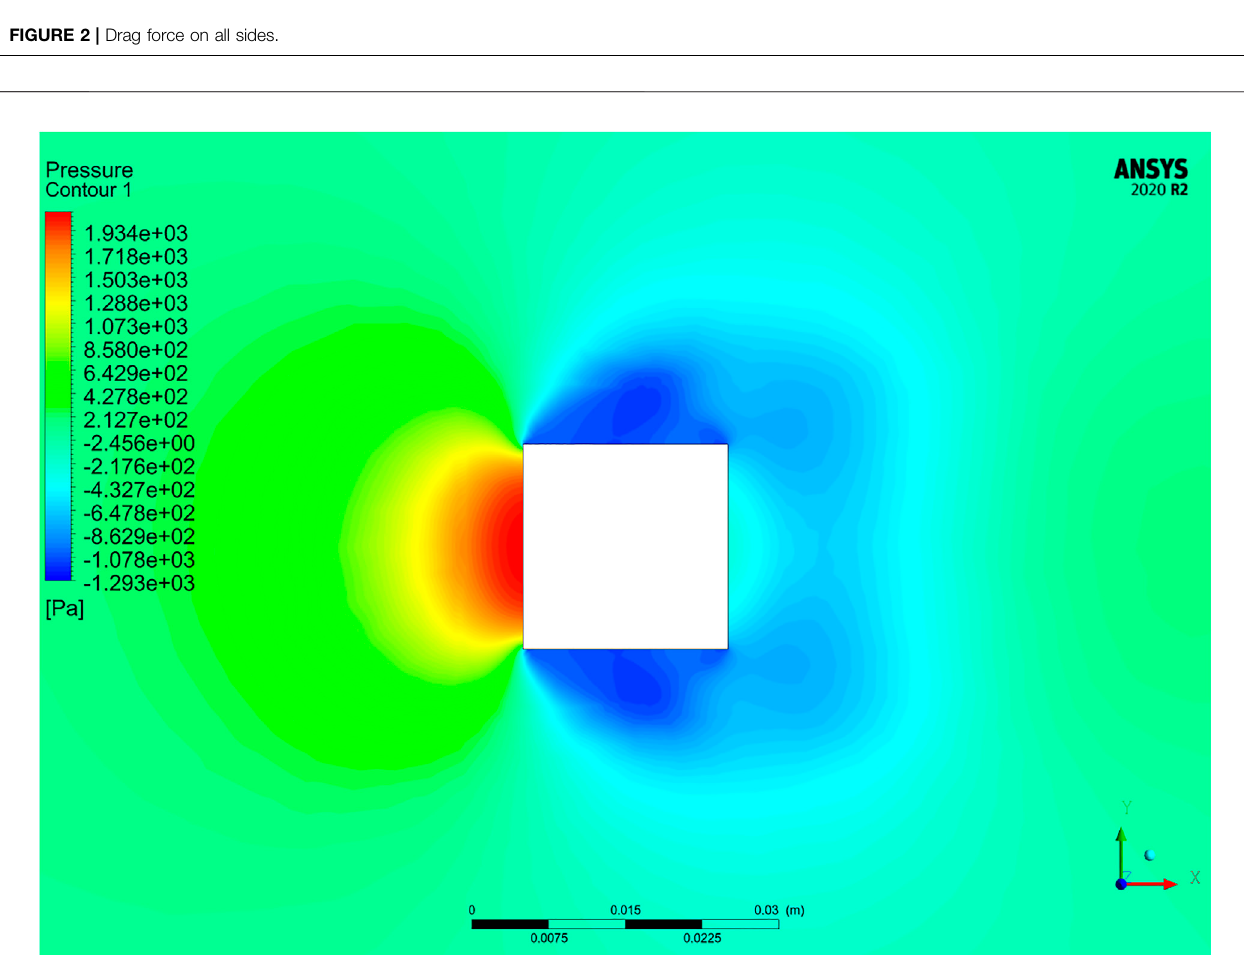
FIGURE 3 | Pressure cloud diagram.